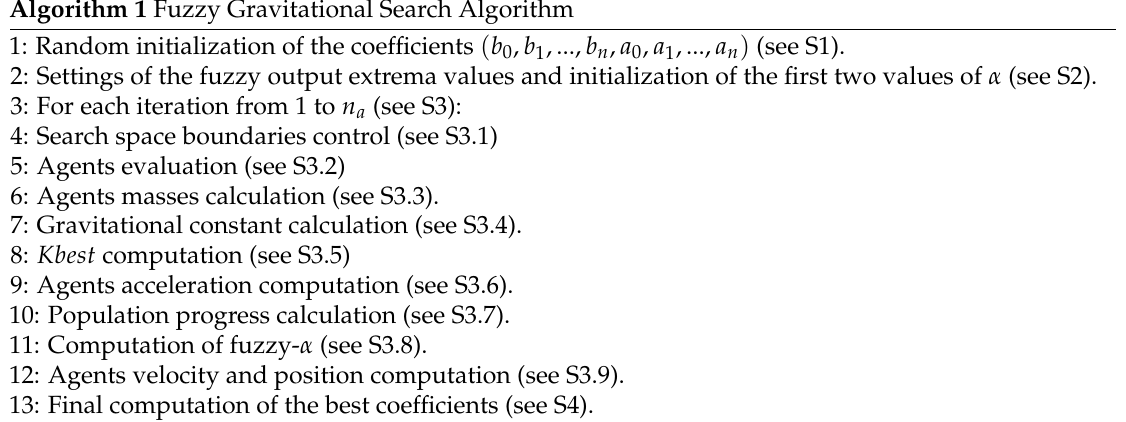
Algorithm 1 Fuzzy Gravitational Search